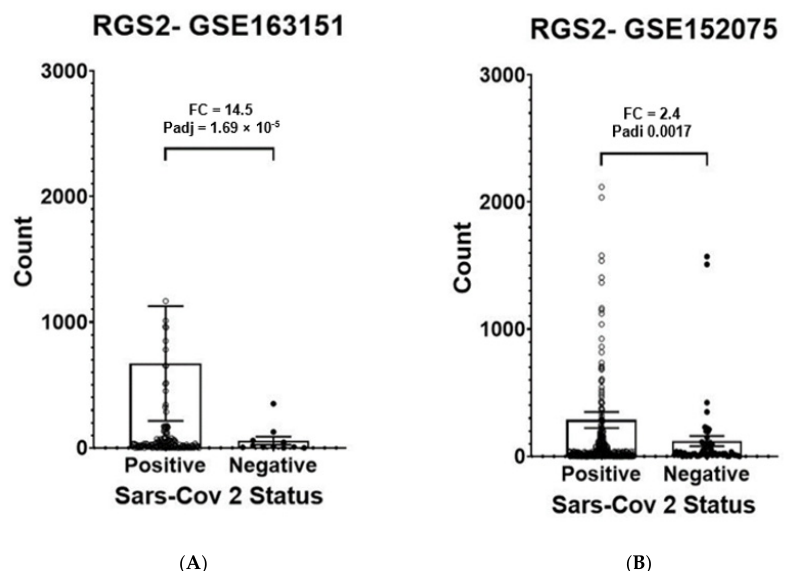
Figure 1. Expression levels of RGS2 mRNA from RNA-sequencing of nasopharyngeal swabs of SARS-CoV-2 positive patients and negative controls. ( A ) Dataset GSE163151: higher expression of RGS2 (FC = 14.5, padj = 1.69 × 10 − 5 ) in SARS-CoV-2 positive patients (138 samples) vs. negative controls (11 samples). ( B ) Dataset GSE152075: higher expression of RGS2 (FC = 2.4, padj = 0.0017) in SARS-CoV-2 positive patients (377 samples) vs. negative controls (54 samples). Samples with over 3000 RGS2 counts (five and nine SARS-CoV-2 positive patients, respectively) are not shown due to scale limitations but are included in the statistics.